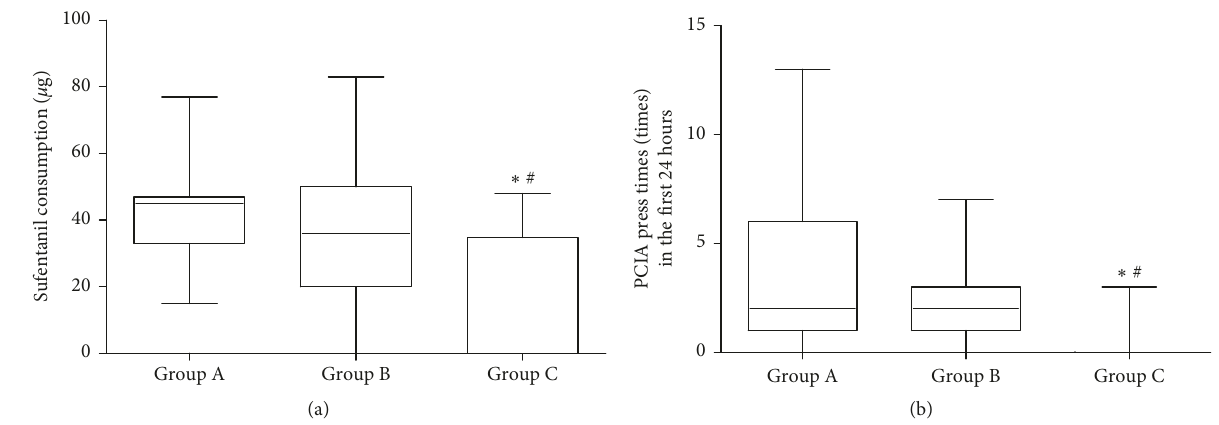
Figure 2: (a). The comparison of the sufentanil consumption ( μ g) in the first 24 hours among the three groups (median (quartiles)). Significantly less sufentanil consumption in Group C than in Group A and Group B. ∗ Comparison between Group C and Group A, p < 0 . 05. # Comparison between Group C and Group B, p < 0 . 05. (b). The comparison of PCIA press times (times) in the first 24 hours among the three groups (median (quartiles)). Significantly less PCIA press times in Group C than in Group A and Group B. ∗ Comparison between Group C and Group A, p < 0 . 05. # Comparison between Group C and Group B, p < 0 . 05.